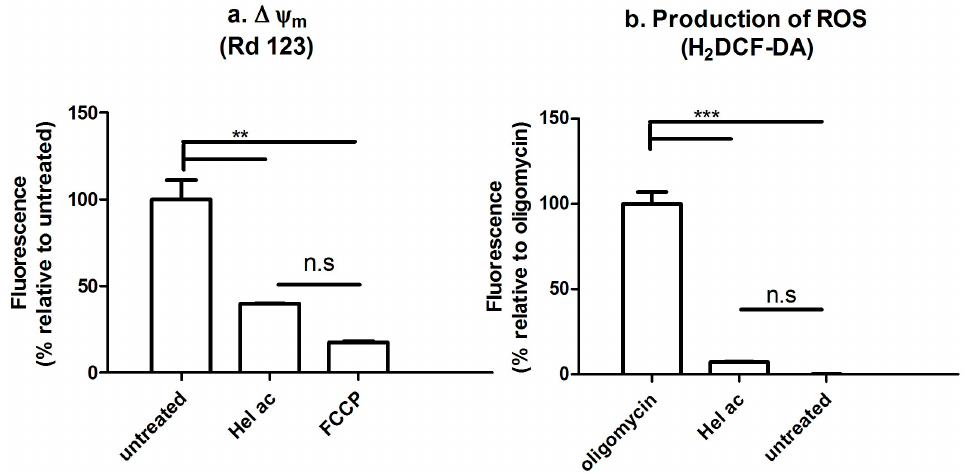
Figure 3. ( a ) Depolarization of the mitochondrial membrane potential ( ∆ ψ m ) and ( b ) production of reactive oxygen species (ROS) of L. (L.) infantum promastigotes treated with compound 1 for 1 h. ( a ) Promastigotes were treated with 1 (6 µ M) and then stained with rhodamine 123 (0.3 µ g/mL) or ( b ) H 2 DCFDA (5 µ M). Data were normalized to the intensity of Rd123 fluorescence achieved in non-depolarized untreated promastigotes ( a ) or H 2 DCFDA fluorescence achieved in promastigotes treated with oligomycin ( b ). In both cases, fluorescence was measured in 10,000 cells using a FL1 at 530 ± 15 nm on a Flow Cytometer Attune Nxt. Error bars depict the mean and standard deviation (SD) of duplicate samples. For each assay, one representative of two independently performed experiments is shown. n.s, not significant; *** indicates significant differences with the control at p < 0.001; ** indicates p < 0.01.